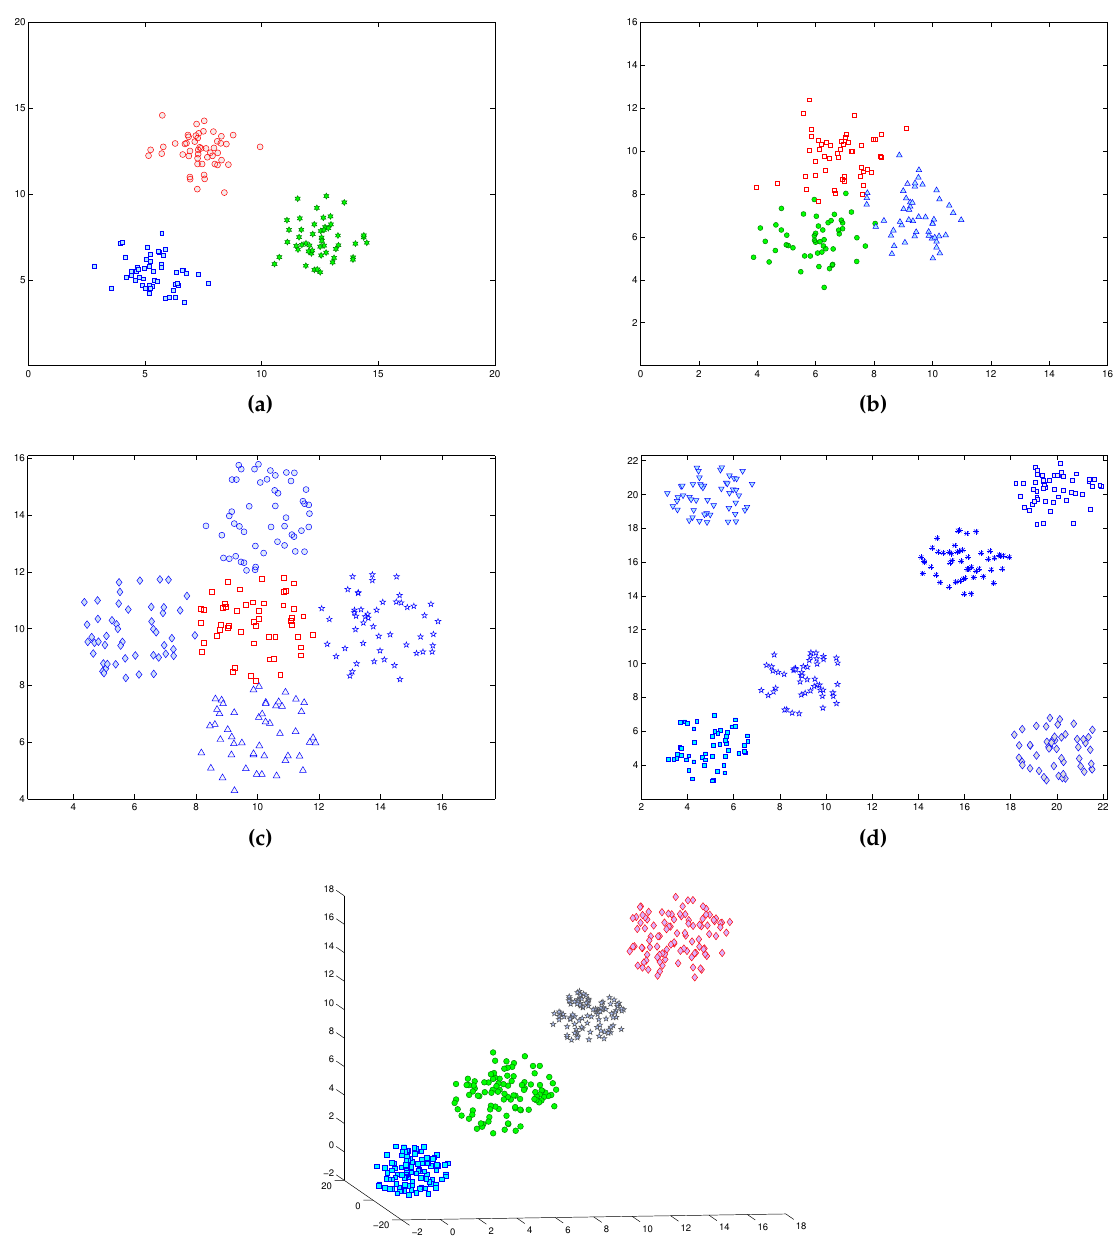
Figure 7. Synthetic datasets used in comparison, ( a ) Separate 3, ( b ) Overlap 3, ( c ) Overlap 5, ( d ) Separate 6 and ( e ) Separate